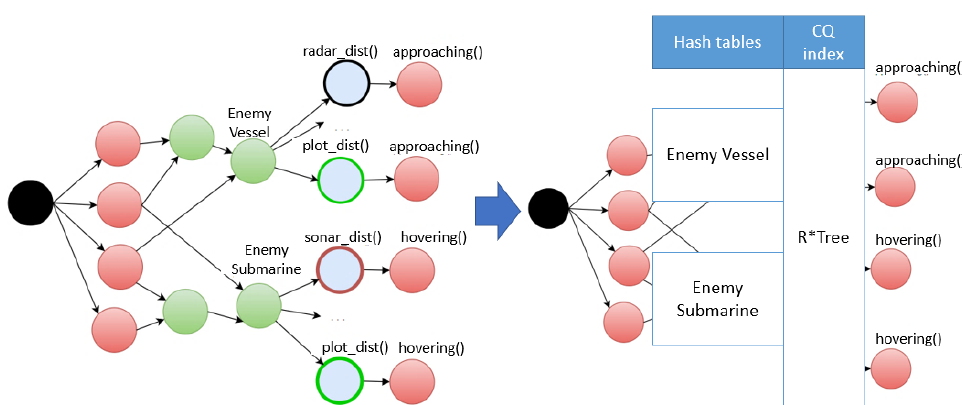
Figure 5. Examples: introduction of hash indexes for beta nodes. Algorithm 1. Rule Insertion (r).